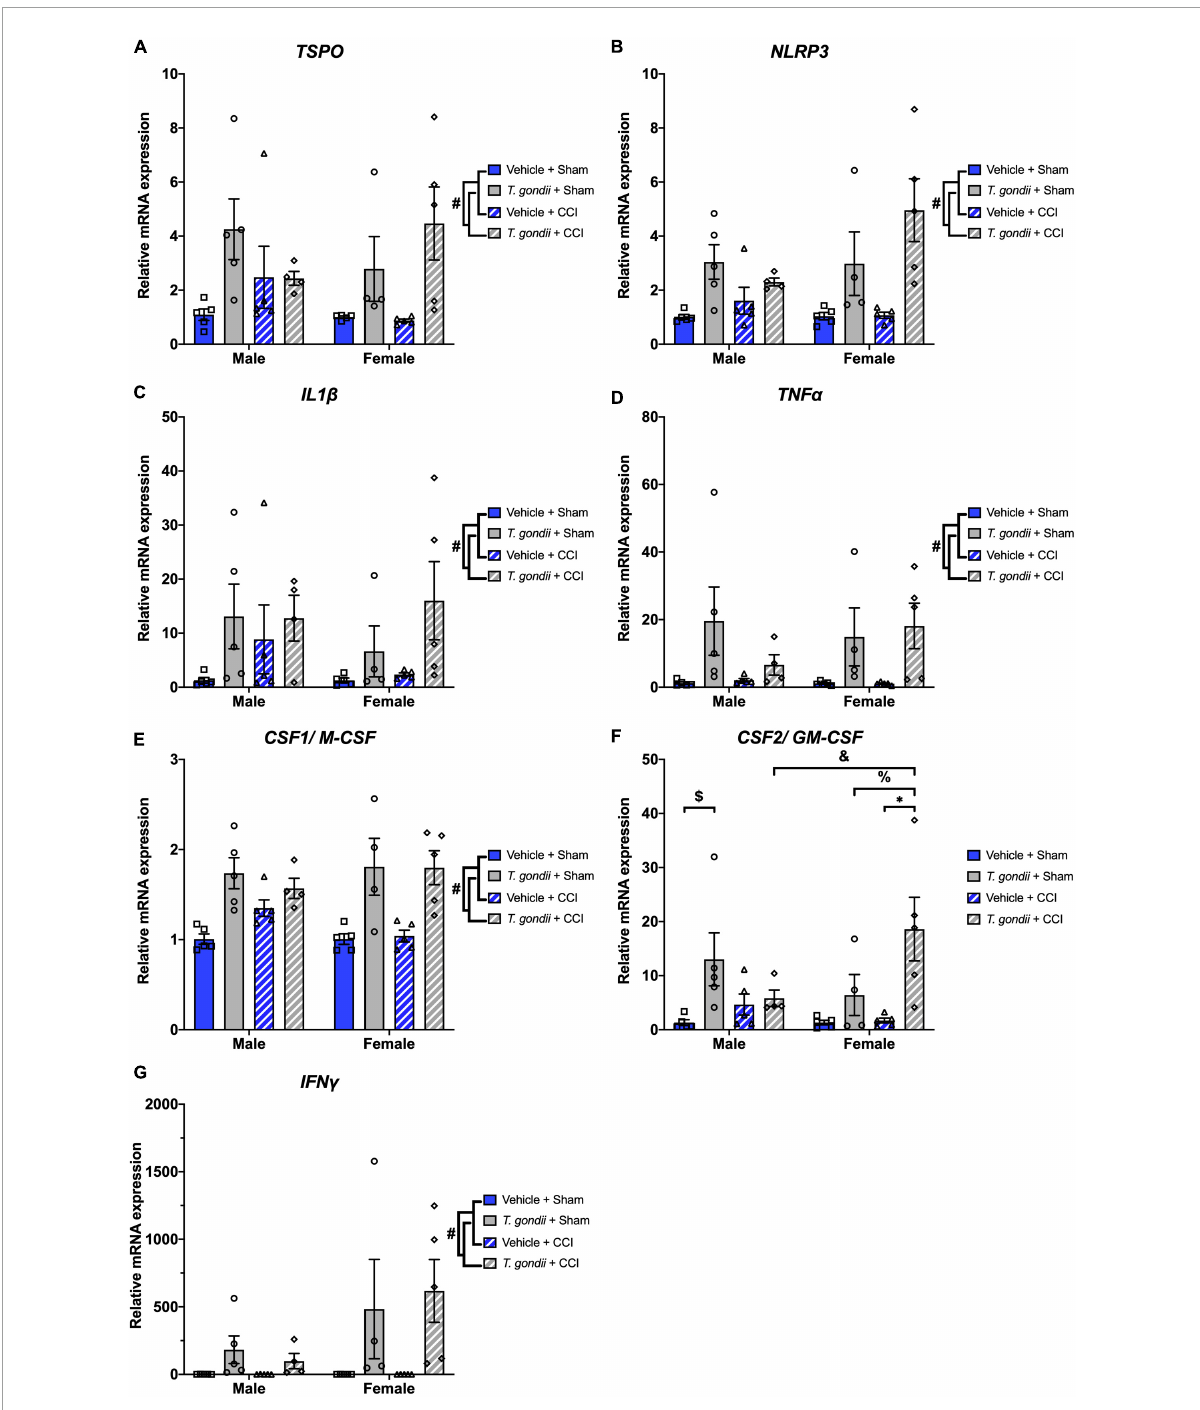
FIGURE6 Chronic Toxoplasma gondii infection increases gene expression of neuroinflammatory mediators in both sexes. Increased expression of TSPO (A) , NLRP3 (B) , IL1 β (C) , TNF α (D) , CSF1/M-CSF (E) , CSF2/GM-CSF (F) , and IFN γ (G) was increased in T. gondii -infected mice compared to vehicle mice. Further to this, T. gondii + controlled cortical impact (CCI) females also had increased expression of CSF2/GM-CSF compared to T. gondii + CCI males, T. gondii + sham females, and vehicle + CCI females. T. gondii + sham males also had increased expression of CSF2/GM-CSF compared to vehicle + sham males. # T. gondii -infected mice significantly differ from vehicle mice, $ T. gondii + sham males significantly differ from vehicle + sham males, & T. gondii + CCI males significantly differ from T. gondii + CCI females, % T. gondii + sham females significantly differ from T. gondii + CCI females, ∗ vehicle + CCI females significantly differ from T. gondii + CCI females, p < 0.05. n = 4–5/group/sex. Data shown is mean ±